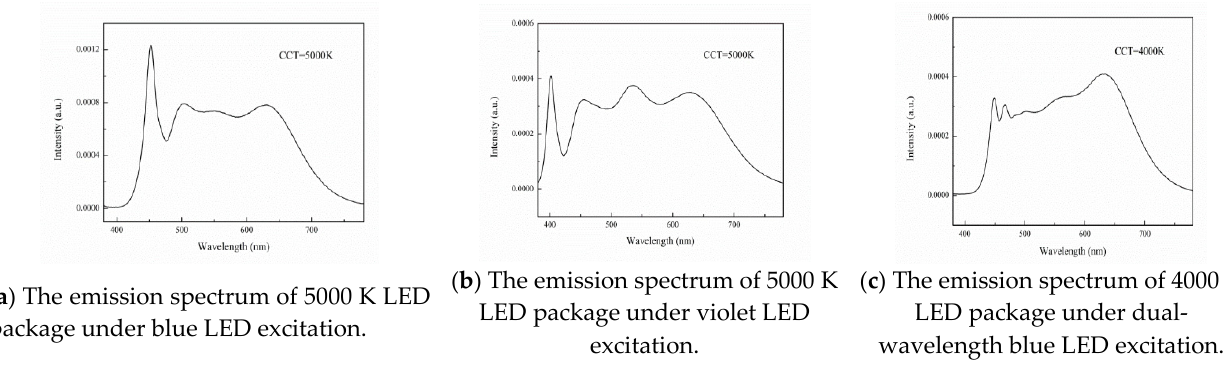
Figure 4. Intensity and spectral distribution of different combinations of LED visible light emitters [72].